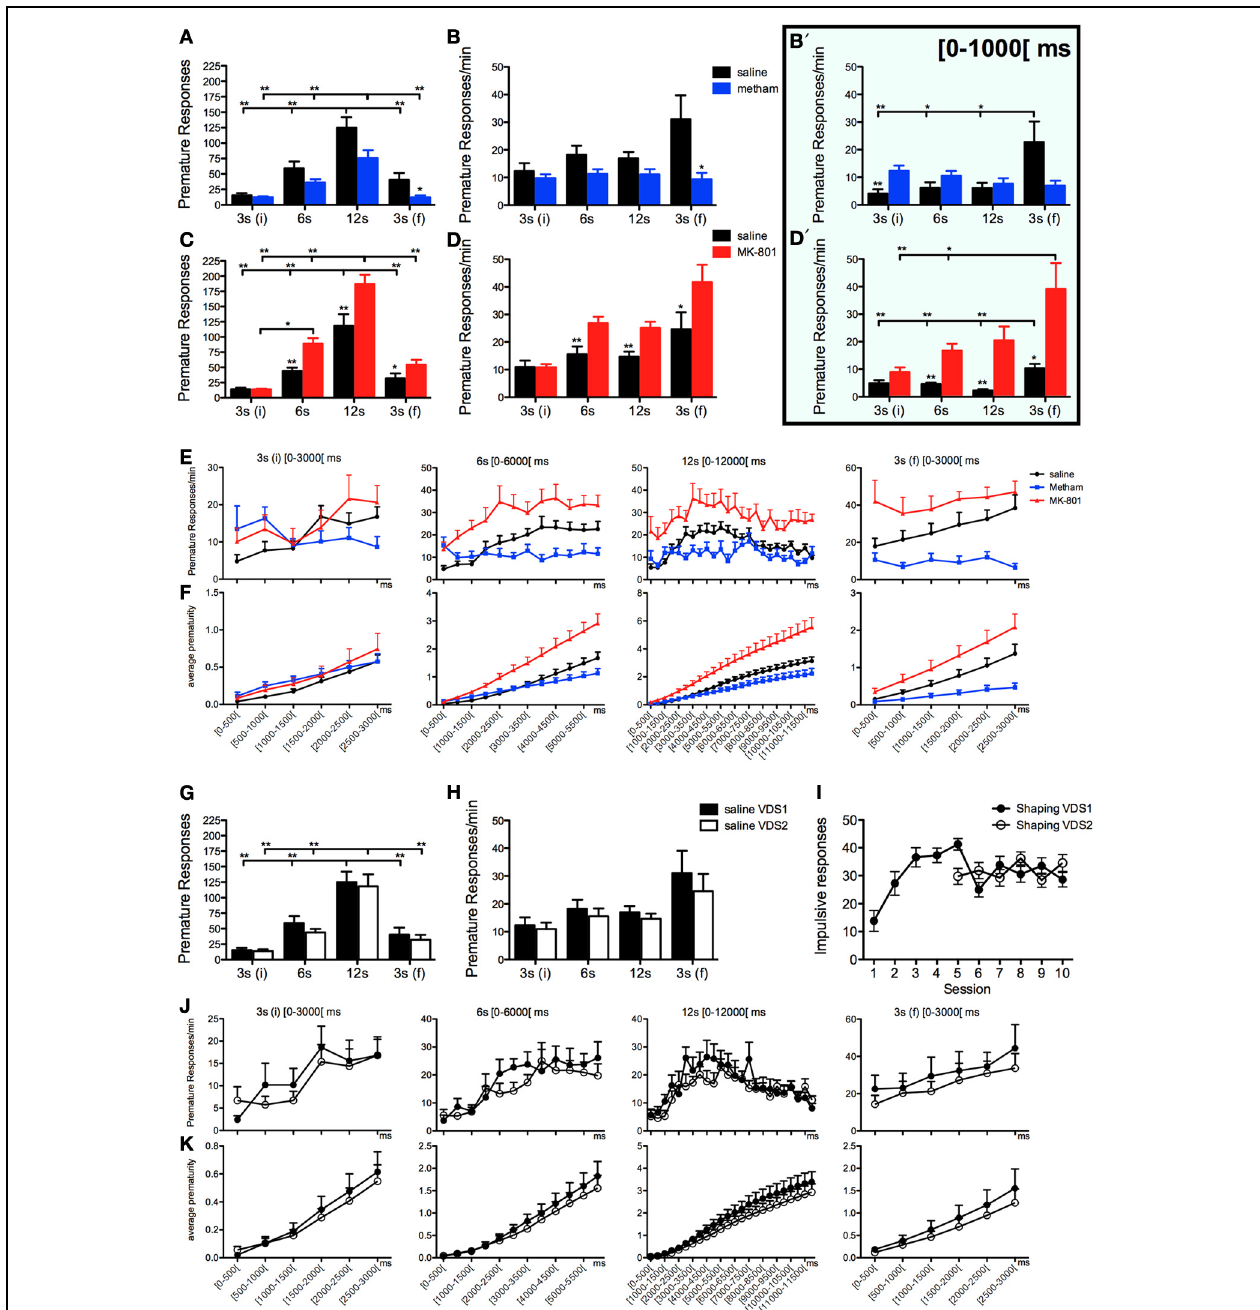
FIGURE 2 | Pharmacological validation of the VDS with methamphetamine and MK-801. (A–F) Methamphetamine (VDS1) and MK-801 (VDS2) decreased and increased, respectively, the absolute number of premature responses (A, C) and the number of premature responses per available minute of delay (B, D) . In the case of methamphetamine, but not MK-801, this pattern was inverted in the initial second of the 3s (i) delay segment (B (cid:6) , D (cid:6) ) . The absolute (E) and the accumulated (F) average prematurity/trial response profile is presented in a segmented (500ms periods) fashion for each delay segment 3s (i), 6, 12, and 3s (f). The same analyses are presented to